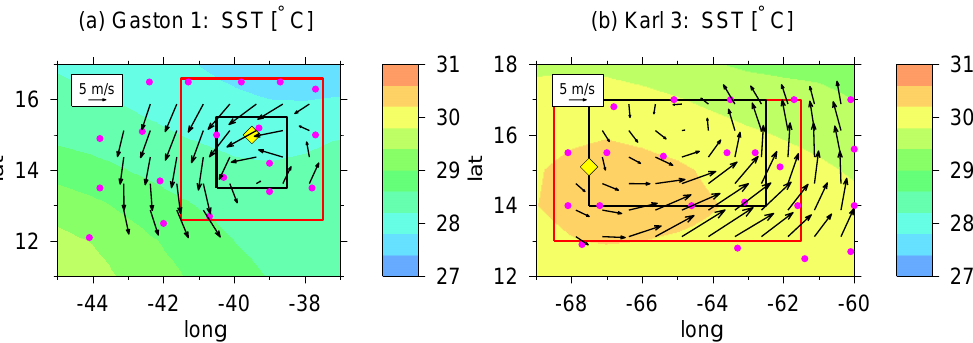
Fig. 8. Reynolds SST (units are ◦ C) for Gaston 1 (left) and Karl 3 (right). The vectors represent the relative wind, averaged over the lowest kilometer. The purple dots indicate dropsonde positions, and the yellow diamond marks the circulation center at 5 km.